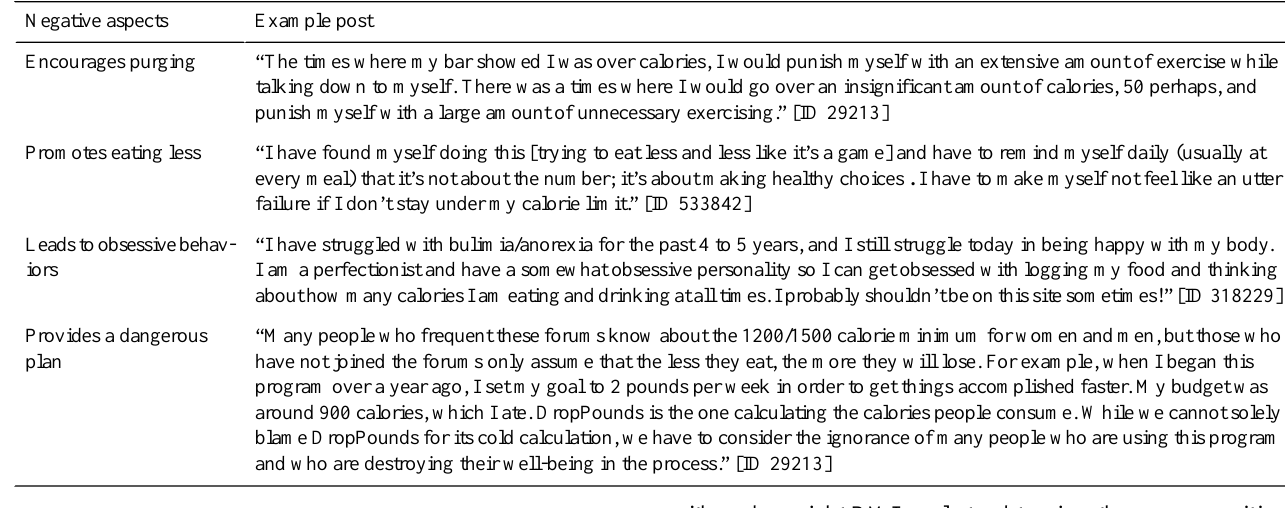
Example postNegative